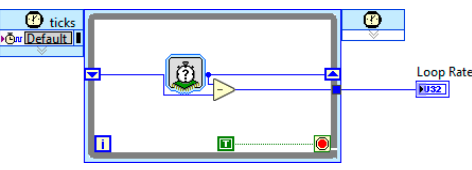
Figure 11. Program employed to obtain the clock cycles per iteration.